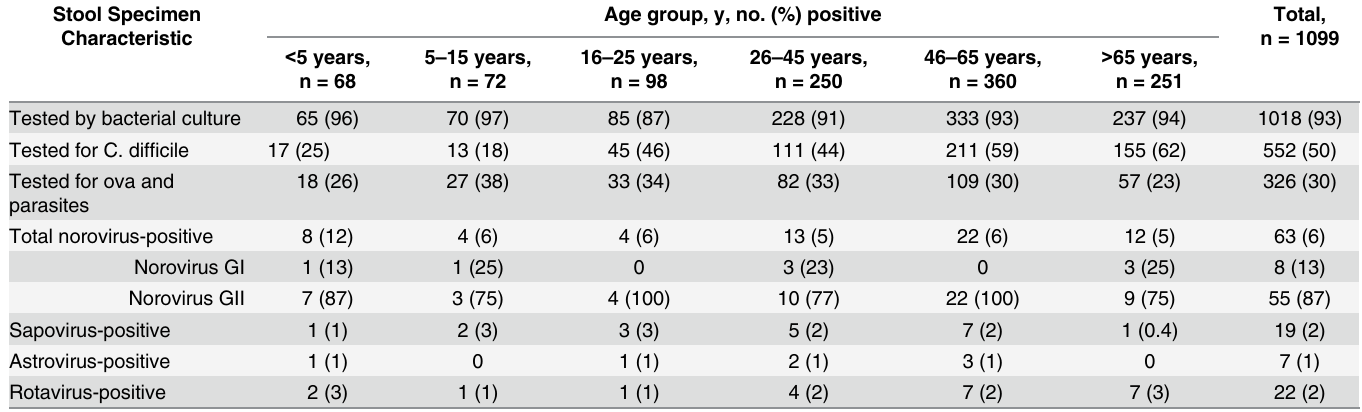
Table 1. Characteristics of randomly selected stool specimens submitted by outpatients, by age group, to Kaiser Permanente Northwest and Mid- Atlantic Health Plans, 2012 – 2013. Stool Specimen